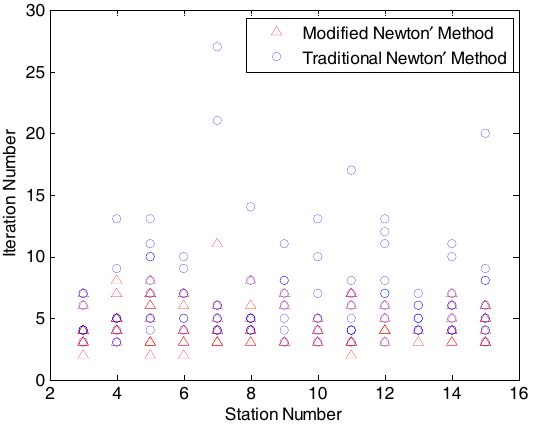
Figure 10. Comparison of maximum iteration between Modified Newton’s Method and traditional Newton’s Method for different stations.